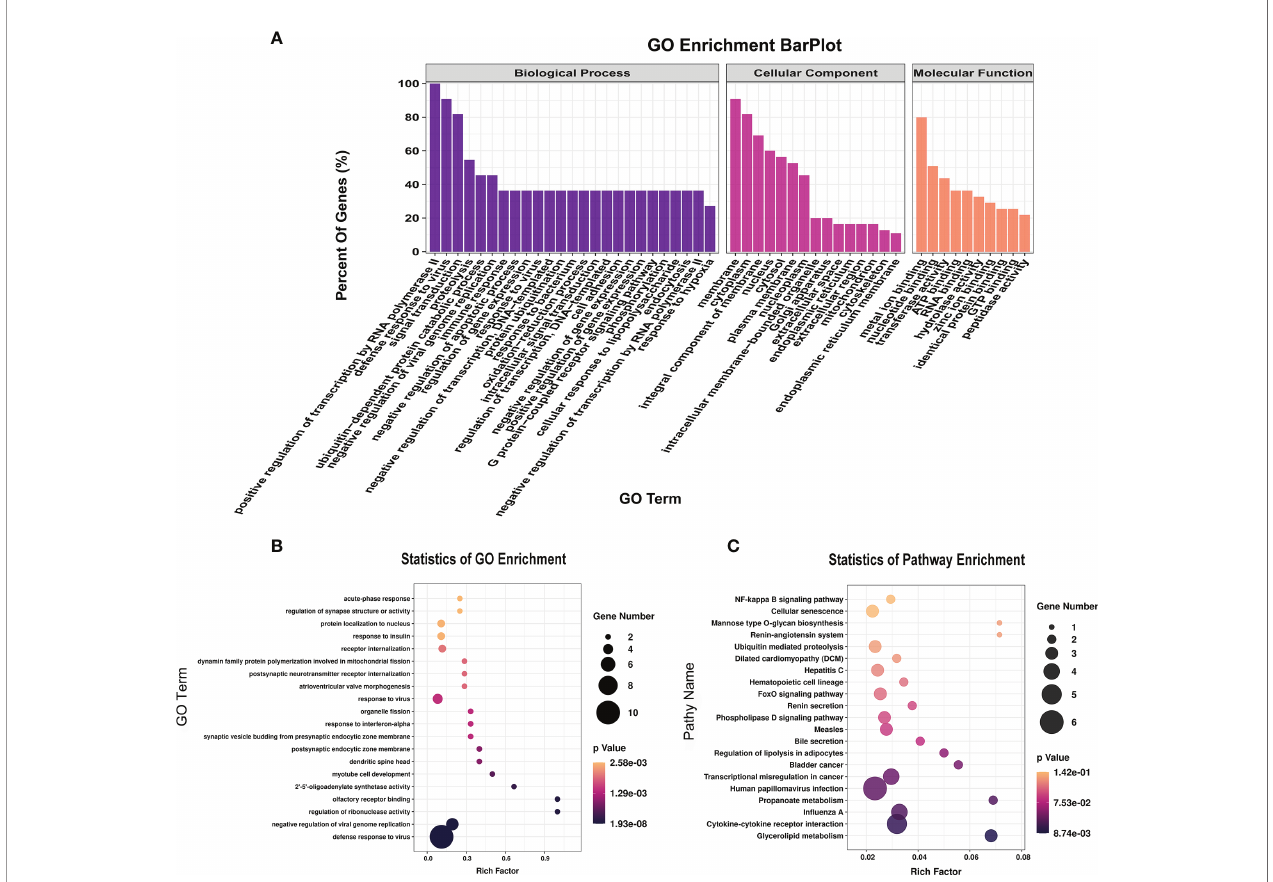
FIGURE 6 | The distribution and functional analysis for differential m6A-modi fi ed lncRNAs. GO enrichment (A, B) and KEGG signaling pathway analysis (C) of the target genes of differentially m6A modi fi ed lncRNAs.